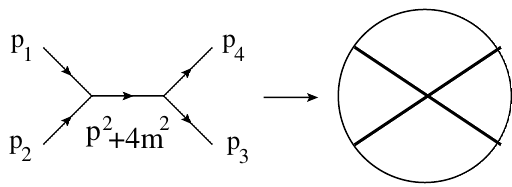
Figure 1 . The factorization singularity of s -channel diagram leads to a contact Witten diagram in AdS 3